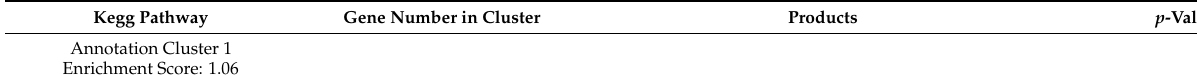
Table 6. DAVID enrichment analysis of the transcriptome DEGs in 1-R vs.